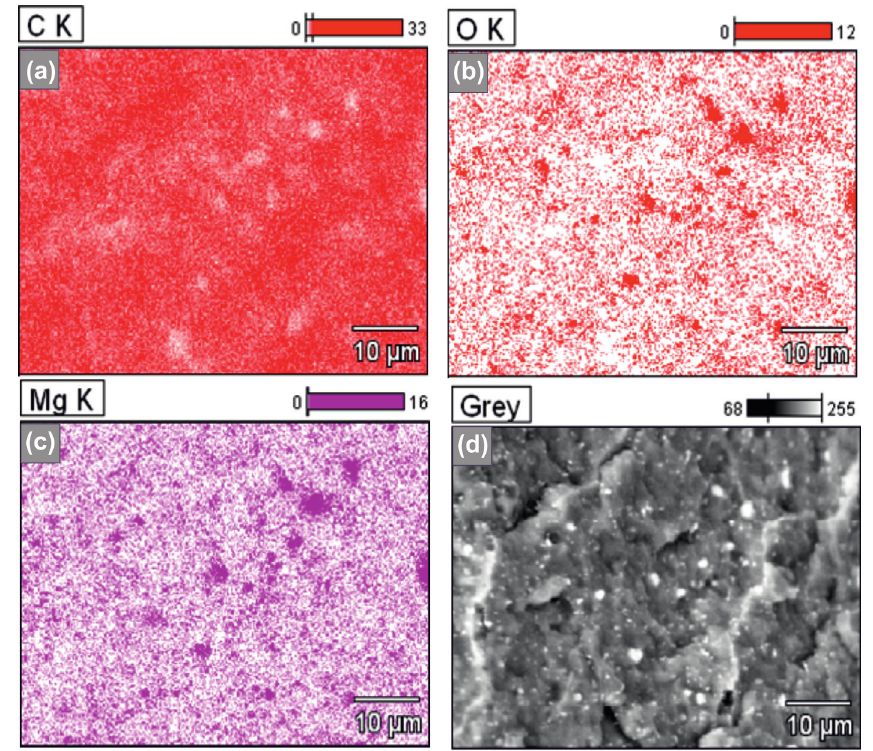
Figure 7: X-ray maps of ( a) carbon; (b) oxygen; (c, d)